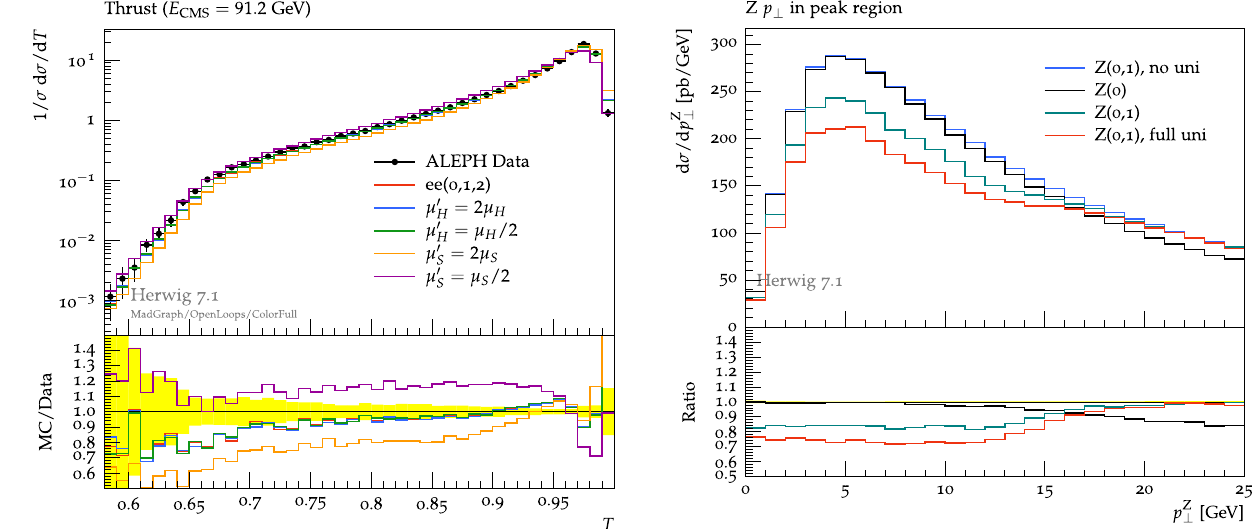
Fig. 12 Scale variation for an ee ( 0 , 1 , 2 ) merged sample, compared with data [64]. Since the LO is independent of the renormalization scale the variation of the hard scale argument does not affect the contribution. Variationoftheargumentofthecouplingconstantusedintheshowering process, however, leads to more spherical events by lowering the scale and more pencil-like events by enhancing the scale argument